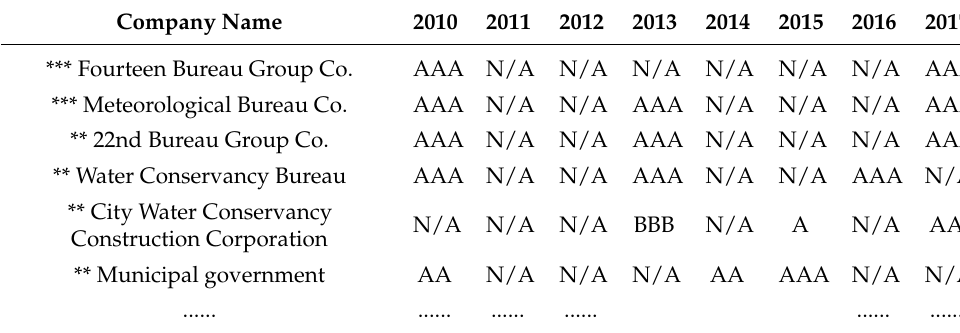
Table 4. Information on the ability level of some subject in the past years.